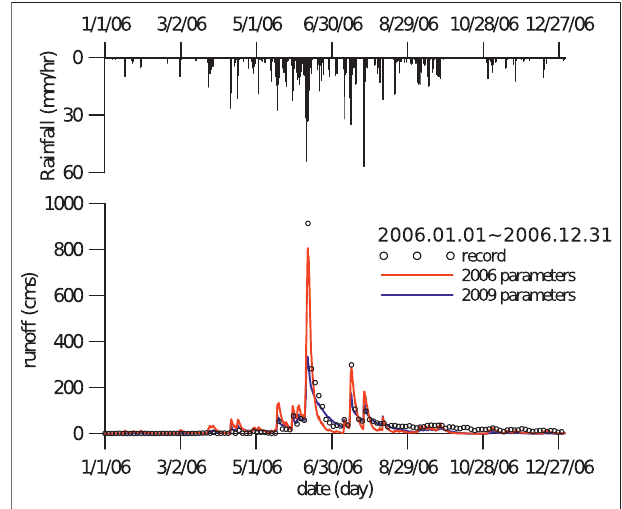
FIGURE 9 | Calibrated river runoff volume fl ow rate of the TienChih catchment for 2006. The volume fl ow rate data were recorded by the A-Chyi- Ba Bridge station of the Laonung River. The volume fl ow rate prediction using the 2009 tank model parameters is also superposed for comparison.